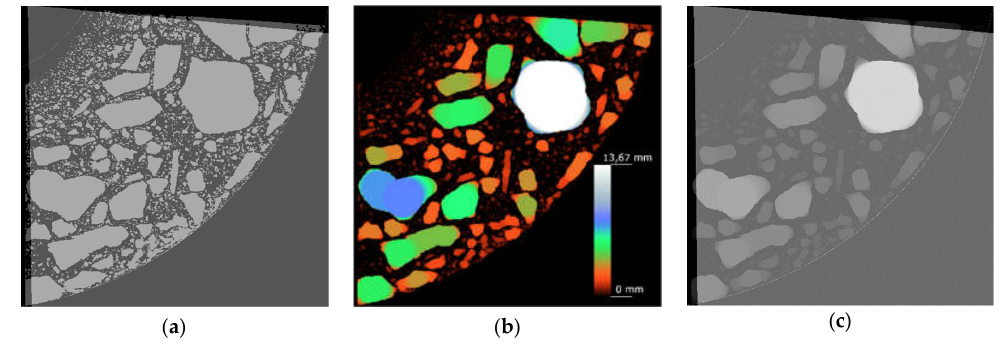
Figure 17. Results of applied morphological transformations: ( a ) image of sum of analysed binary image, applied mask defining ROI and outermost circumferential bands taken into account in analysis; ( b ) map of local aggregate size; and ( c ) image of sum of local aggregate size, applied map defining ROI and outermost circumferential bands taken into account in analysis.